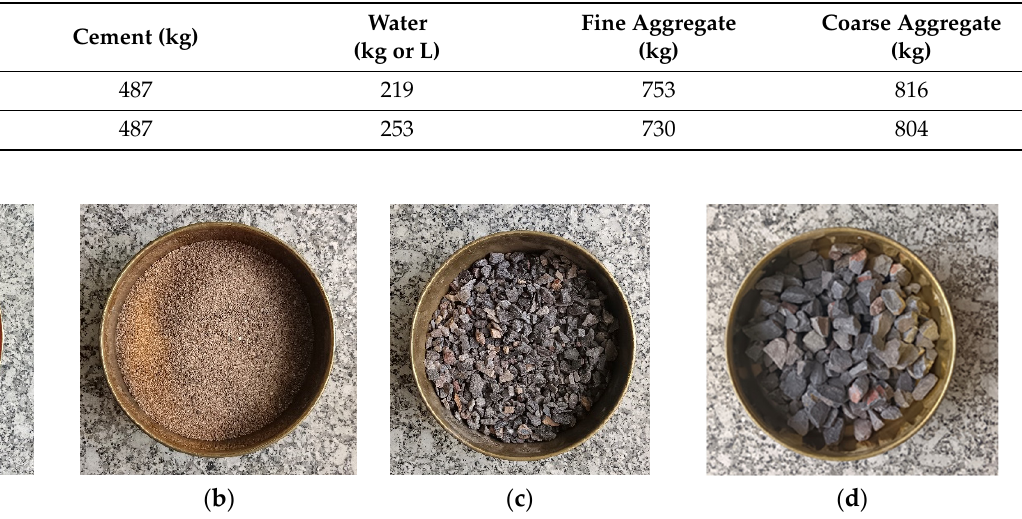
Figure 2. ( a ) Commercial cement; ( b ) river sand; ( c ) natural coarse aggregates (NCA)—10 mm; ( d ) natural coarse aggregates (NCA)—20 mm. Table 2. Mixture proportion per 1 m 3.